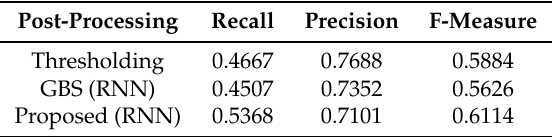
Table 4. Transcription results on the real piano of